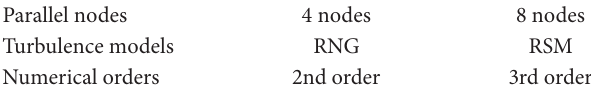
Table 6: Configurations of computing resources. Table 7: Some schemes for CFD simulation.